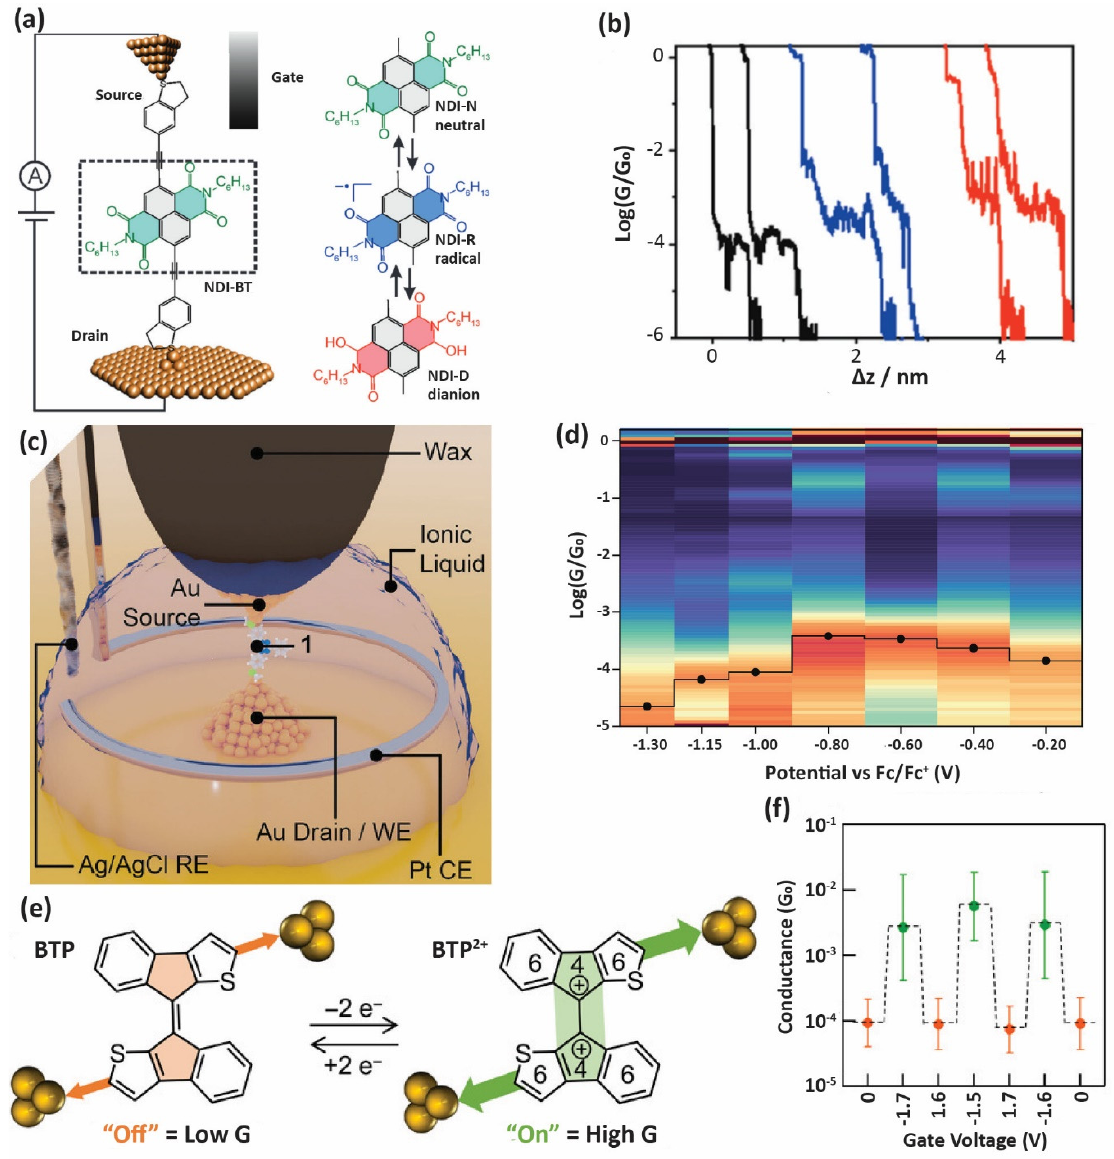
Figure 5. Single-molecule redox reaction in electrochemical break junction. ( a ) Schematic illustration of a redox reaction of naphthalenediimide pendant center via electrochemical gating. ( b ) Traditional conductance vs. distance trace [ND = black, ND 1 − = blue, ND 2- = red]. Figures were reproduced with permission from reference [95]. Copyright 2015, German Chemical Society. ( c ) A four-electrode system of an electrochemical scanning tunneling microscope of a 6-oxoverdazyl radical. ( d ) Heat map of conductance vs. electrochemical potential vs. Fc/Fc + in 1-butyl-3-methylimidazolium ionic liquid (blue is low count, red is high count). Figures were reproduced with permission from reference [97]. Copyright 2022, German Chemical Society. ( e ) Reversible redox reaction of BTP. ( f ) Alternating low/high conductance vs. gate voltage corresponding to the reversible redox reaction of BTP. Figures were reproduced with permission from reference [98]. Copyright 2017, Science Advances.